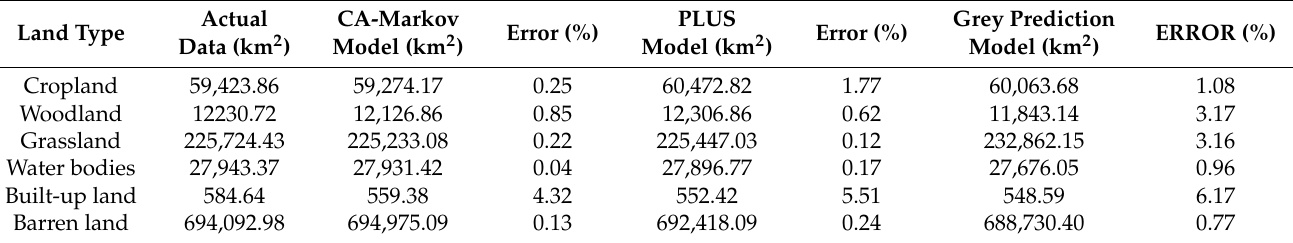
Table 2. Comparison of the simulation results of the three models.